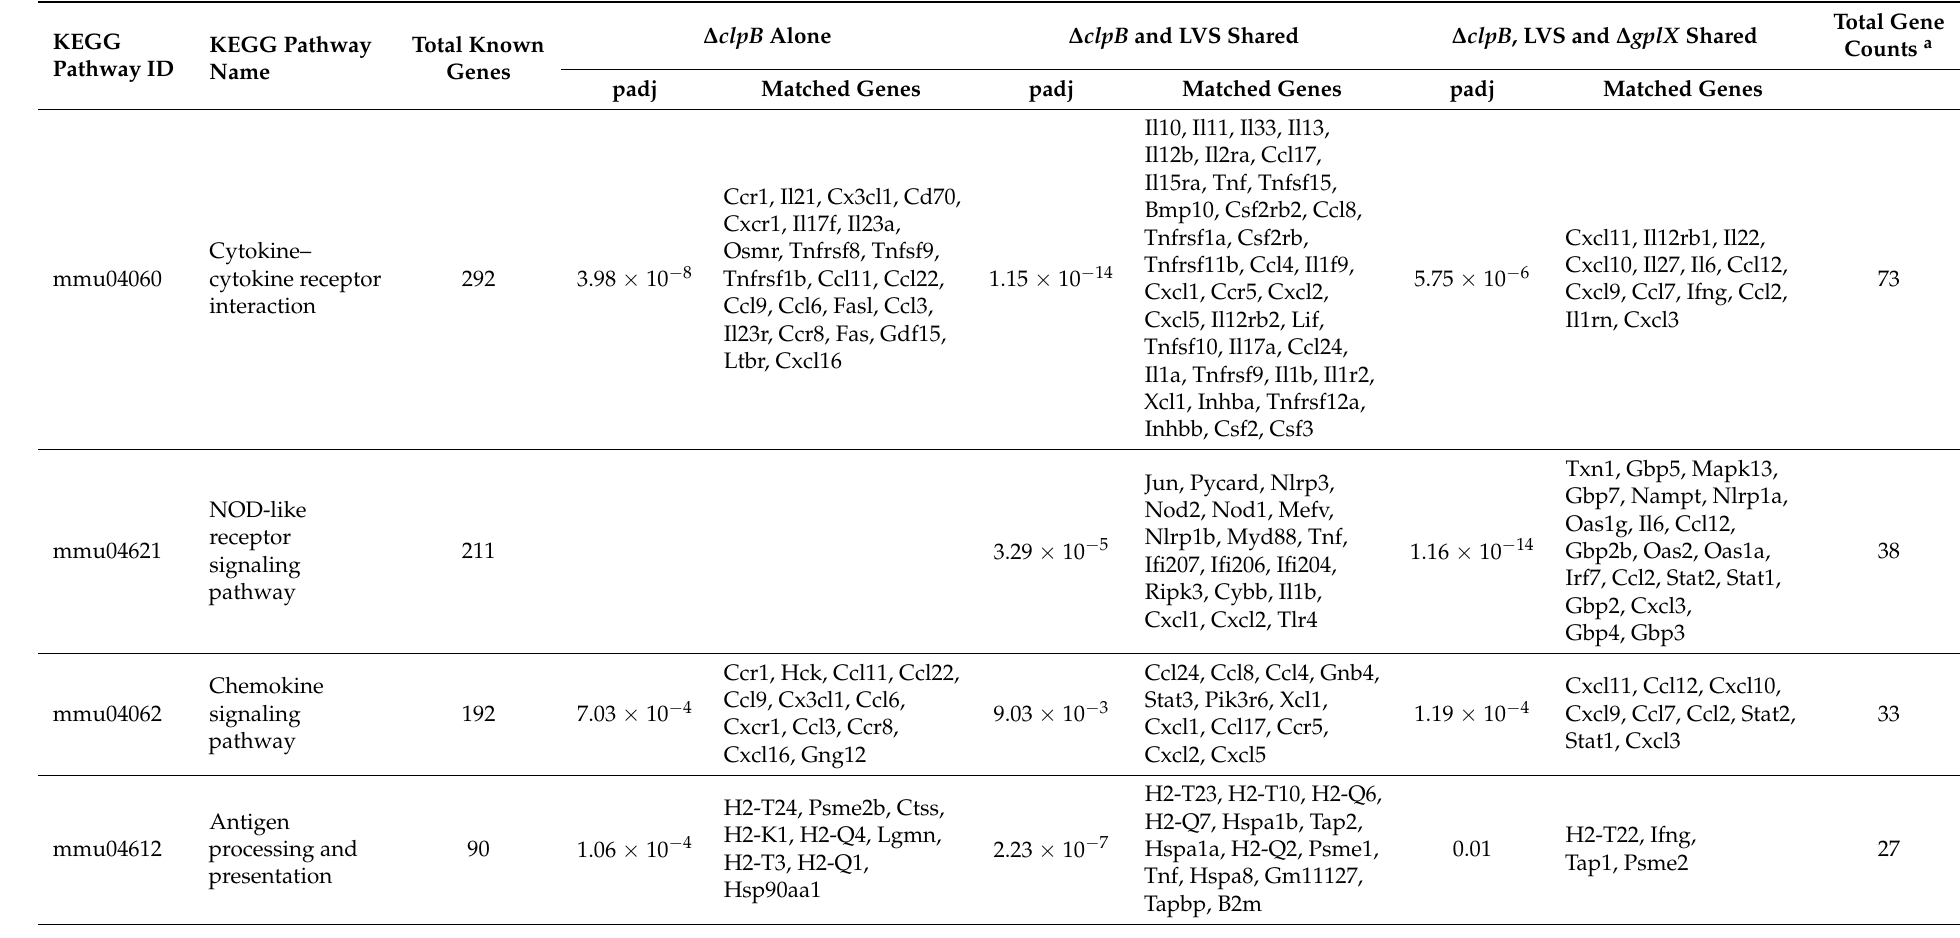
Table 3. Participation of up-regulated genes in KEGG pathways in the three vaccine strains that protect against ID challenge with SCHU S4